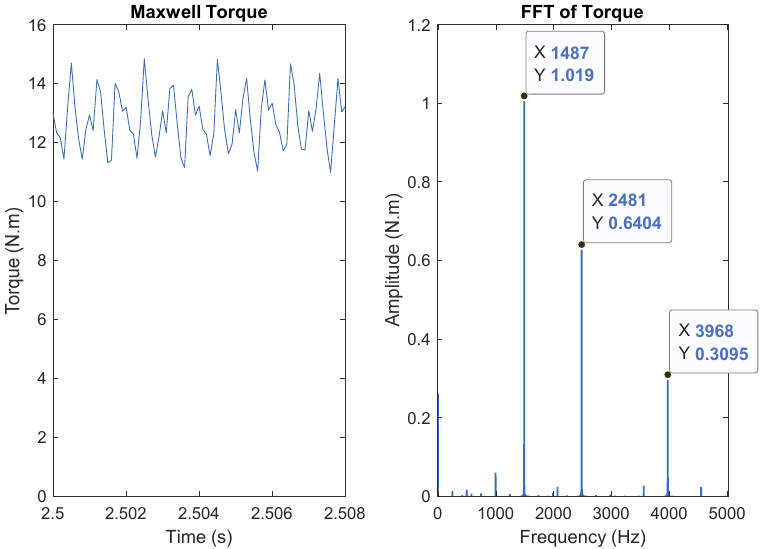
Figure 7. FFT of Finite ‐ Element torque for the five ‐ phase IM with 64 bars. Under sequence “u = 1” (the planes of line (1), Figure 9 are excited).